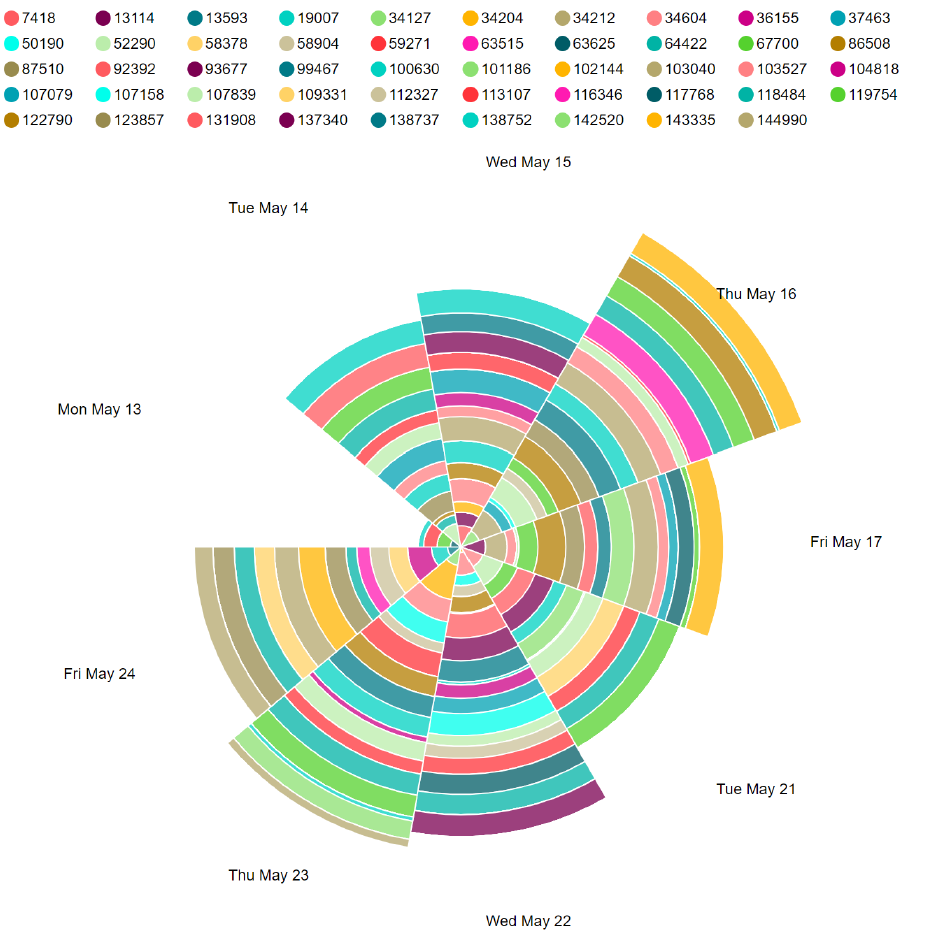
Figure 11. Usage patterns of the top 50